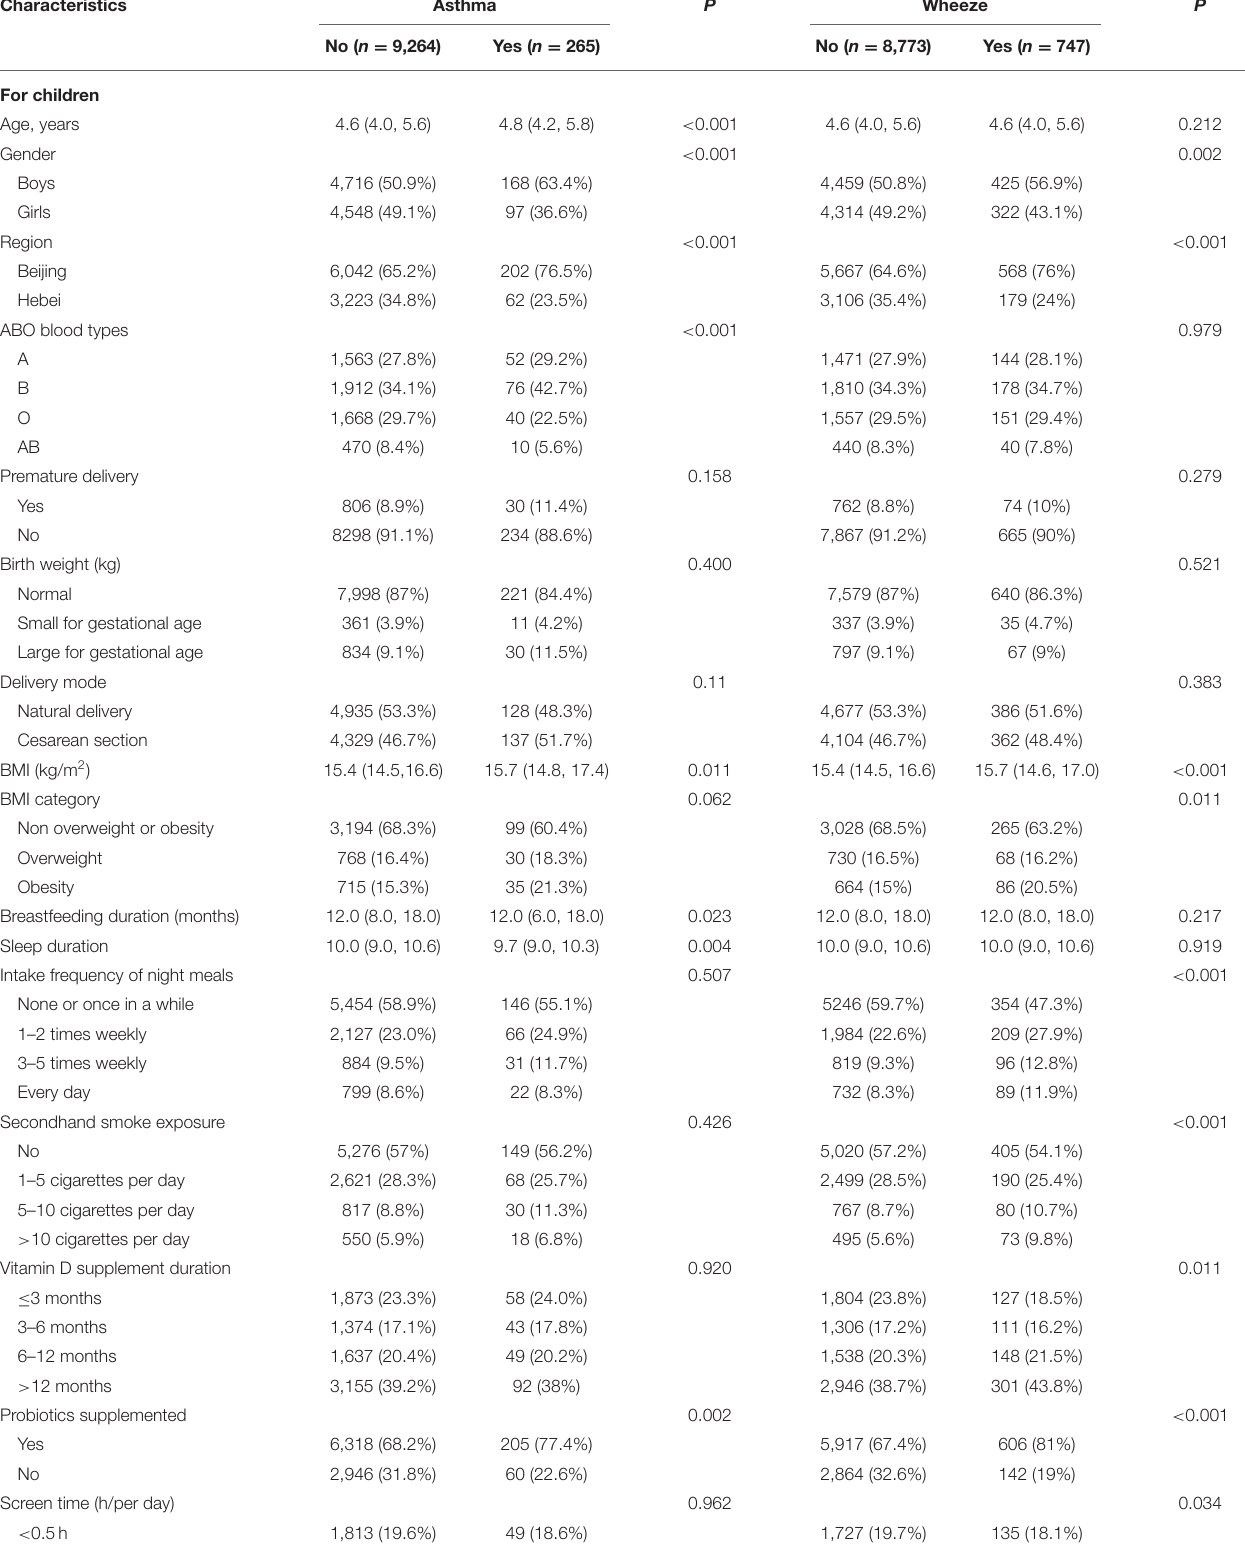
TABLE 1 | Baseline characteristics of study participants in this study.